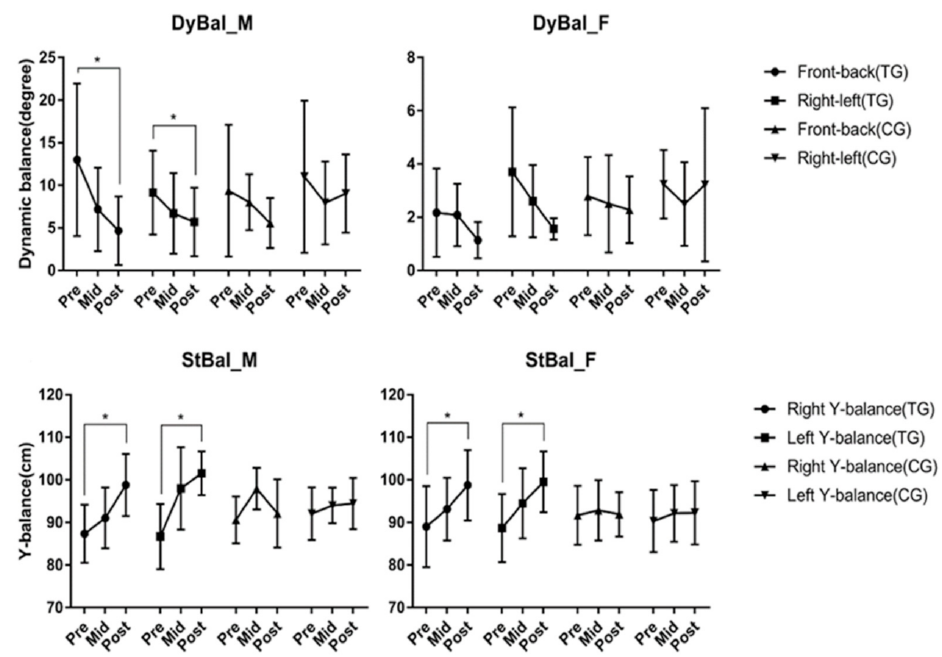
Figure 5. Effects of core balance training on Balance ability. There was a difference according to time in men's Front-Back ( p = 0.004) and Right-Left ( p = 0.039) in dynamic balance ability (DyBal). The static balance ability (StBal) showed a difference accord-ing to time in the male right ( p = 0.003), left (p < 0.001) and group time interaction in right ( p = 0.003). For women, there was a difference according to time in Right ( p = 0.008)-Left ( p = 0.000) and group time interaction in right ( p = 0.003) and left ( p = 0.003). * p < 0.05. Abbreviations: DyBal, dynamic balance ability; StBal, static balance ability; M, male group; F, female group; Pre, pre-test; Mid, mid-test; Post, post-test; TG, training group; CG, control